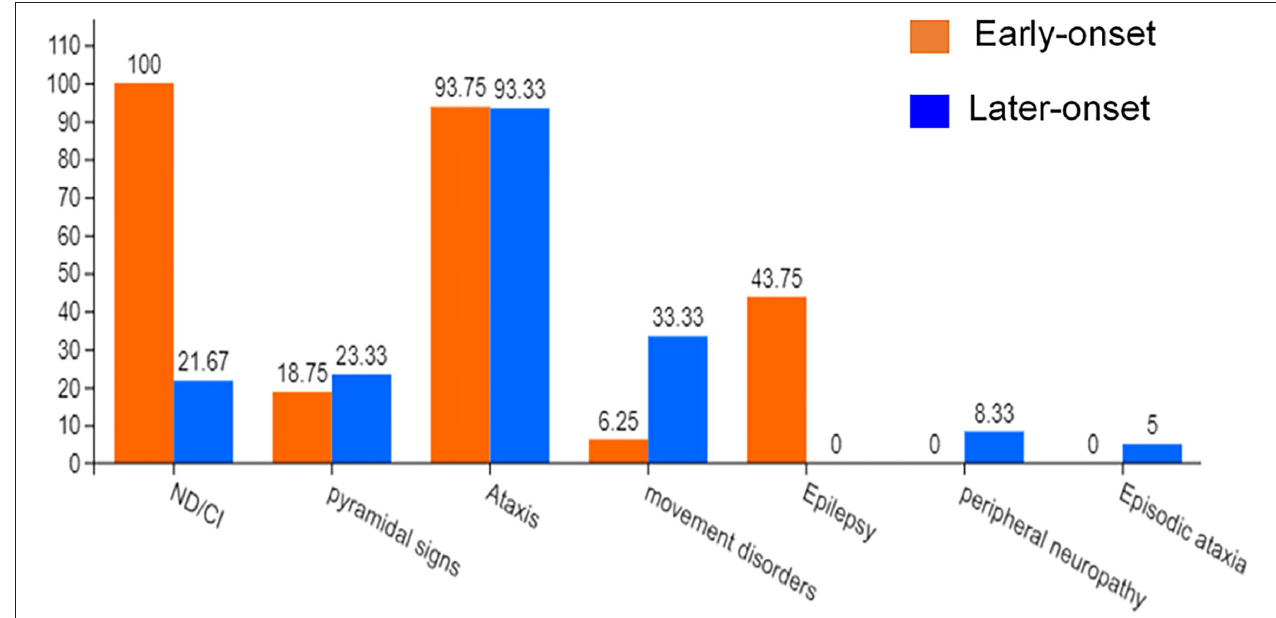
FIGURE 7 | The percentage of symptoms in the early-onset and late-onset cohort. ND, Neurodevelopmental disorders; CI, Cognitive impairment.